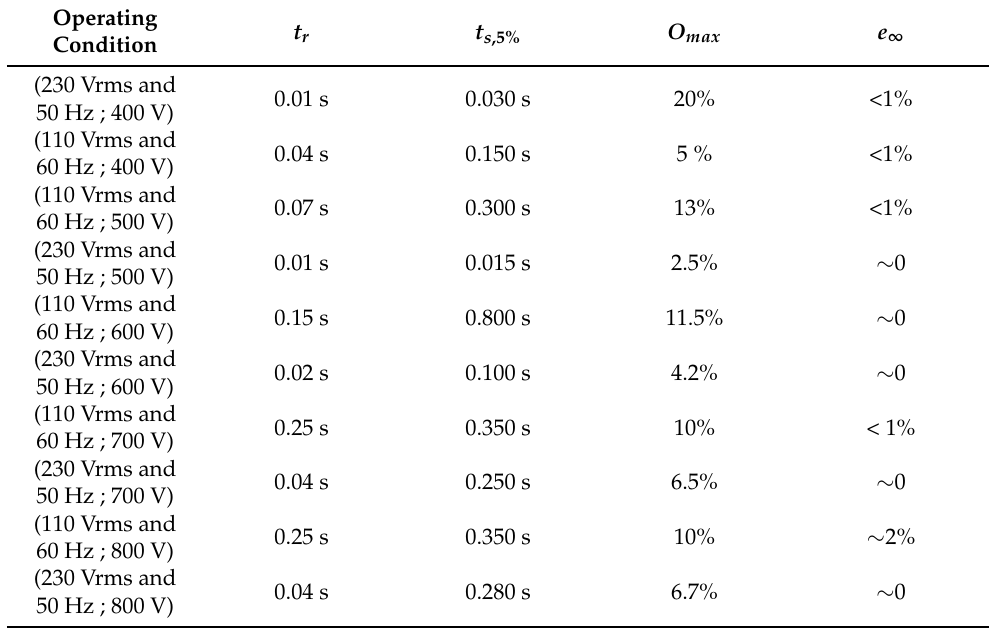
Table 3 summarises the results obtained in terms of voltage step repose for the Totem Pole circuit under the different operating conditions ( V grid and f line ; V ref ). Table 3. Totem Pole PFC simulations summary.